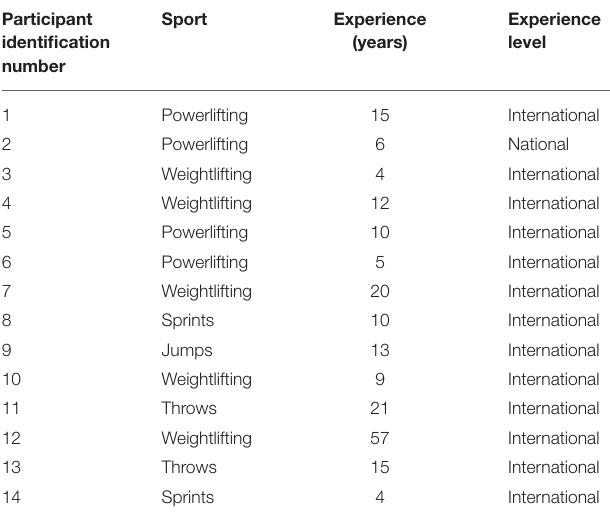
TABLE 1 | Descriptive characteristics of